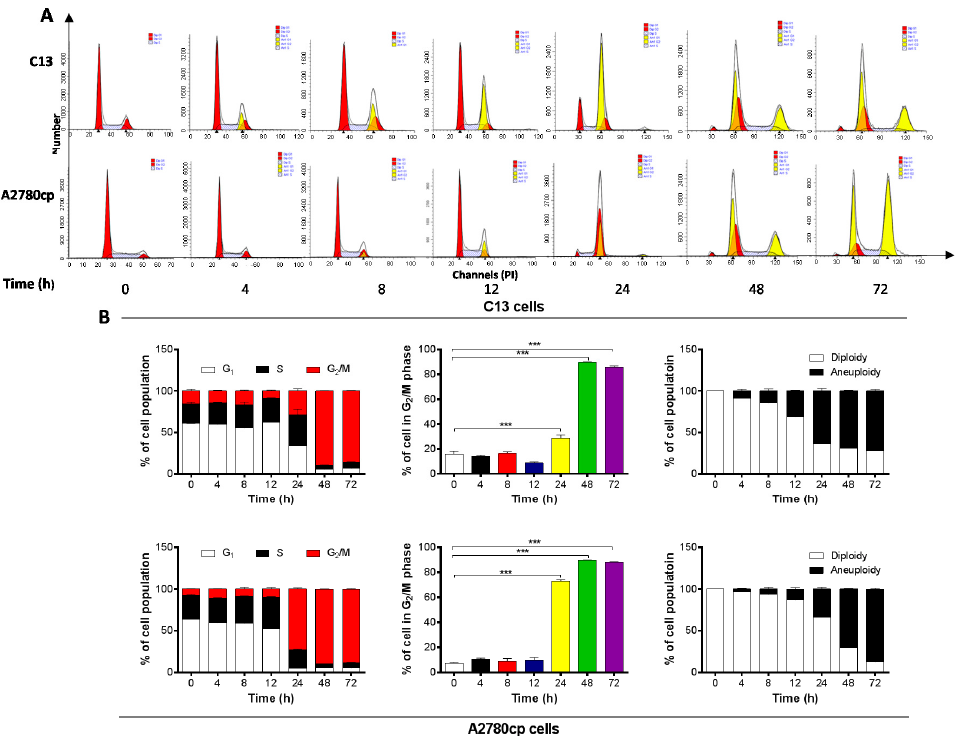
Figure 3. Danu arrests C13 and A2780cp cells in G 2 /M phase over a 72-h treatment period. Cells were treated with 0.5 μ M Danu for 4, 8, 12, 24, 48, and 72 h and then subject to flow cytometry. ( A ) Flow cytometric plots of cell cycle distribution of C13 and A2780cp cells and ( B ) bar graphs showing the percentage of C13 and A2780cp cells in G 1 , S, and G 2 /M phases and the percentage of diploidy and polyploidy in C13 and A2780cp cells. Data represent the mean ± SD of three independent experiments. *** p < 0.001 by one-way analysis of variance.